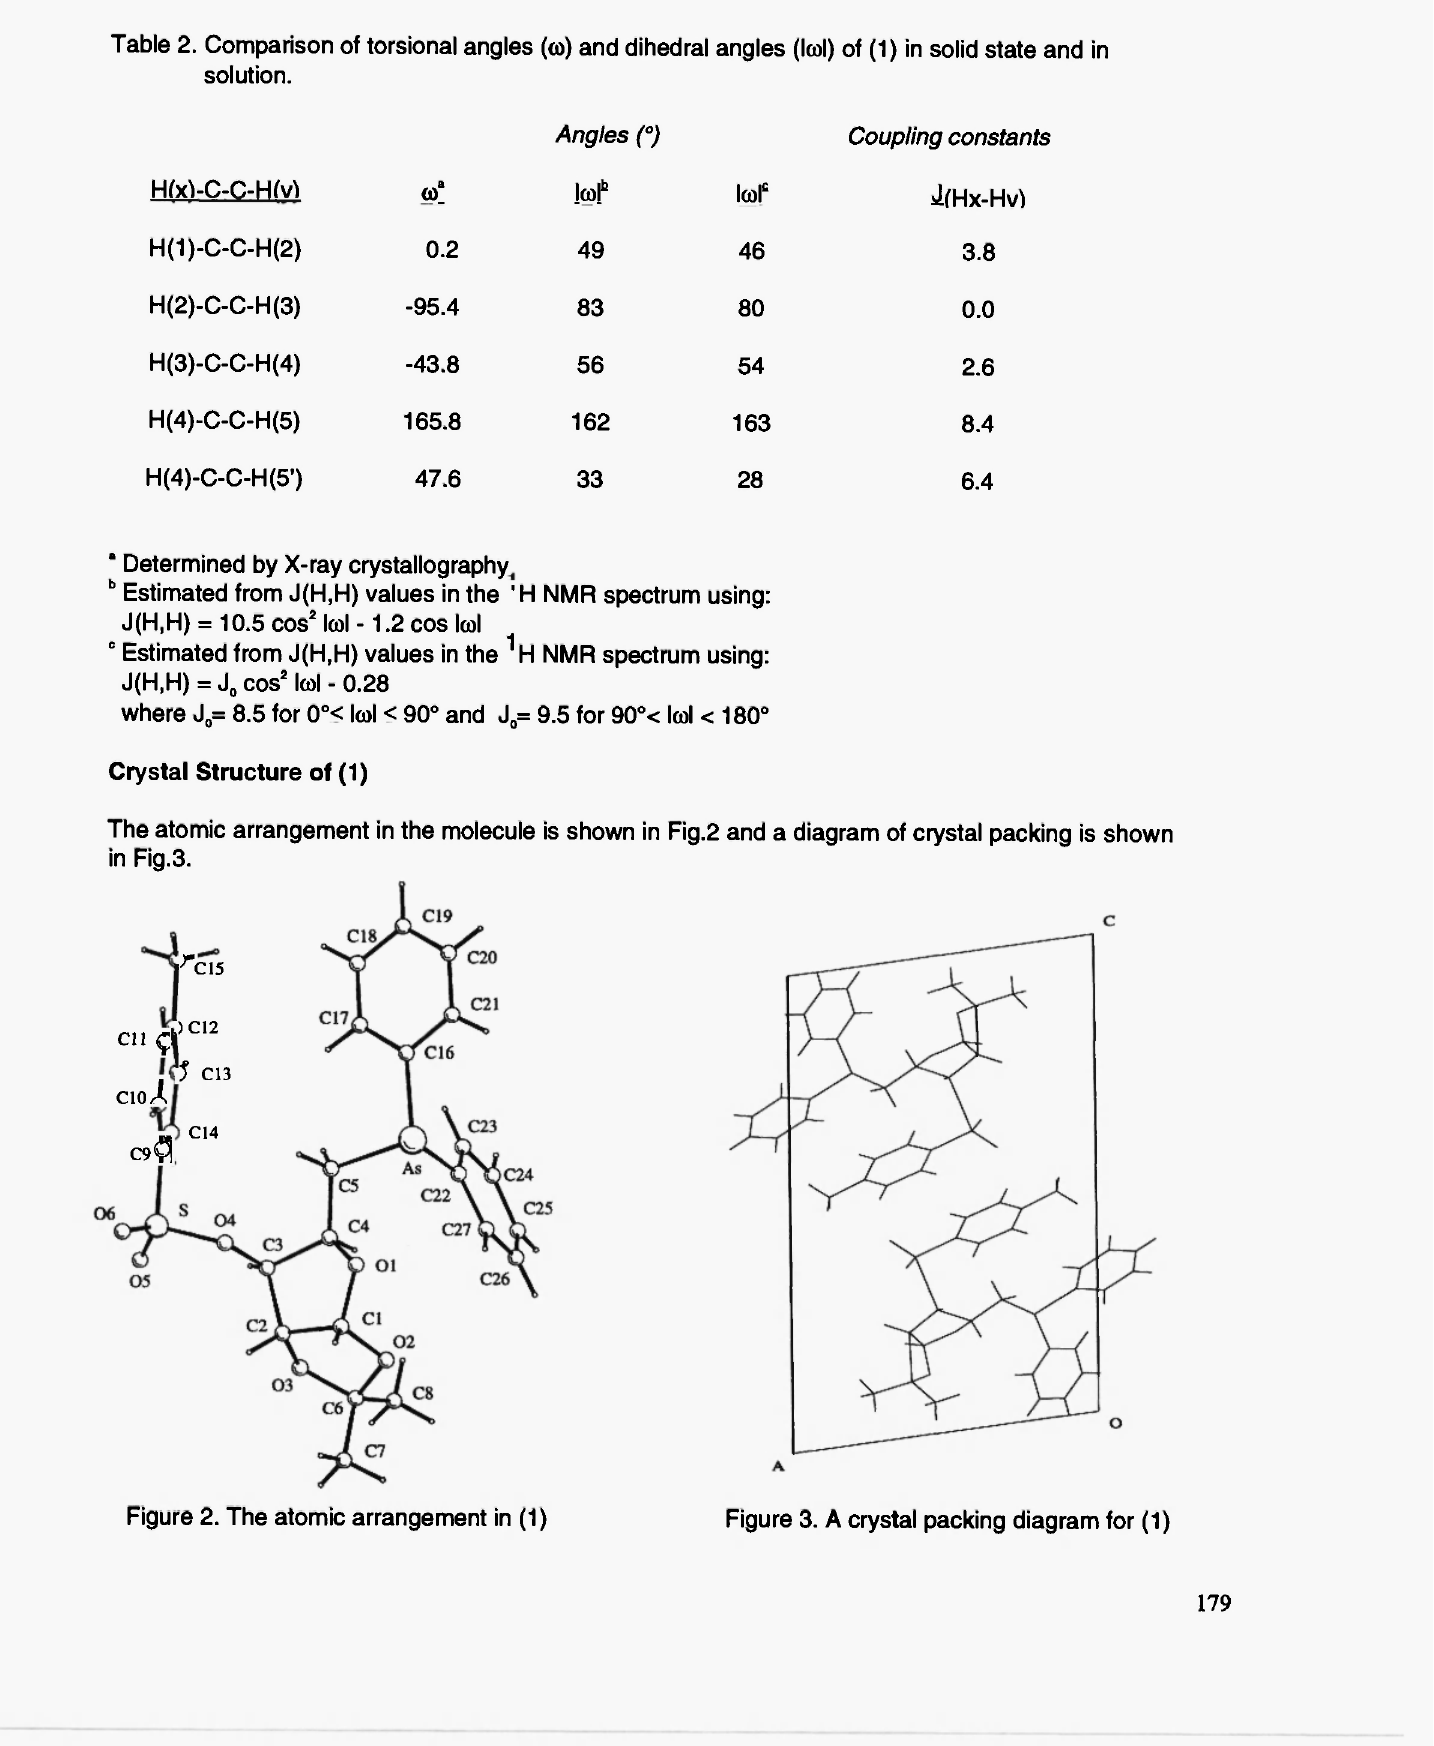
Table 2. Comparison of torsional angles (ω) and dihedral angles (Icol) of (1) in solid state and in solution. Angles (")